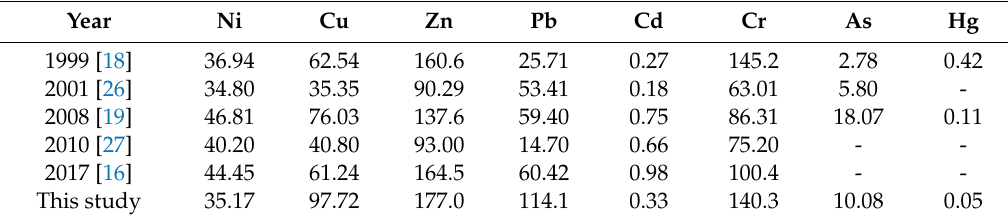
Table 5. Temporal variation of heavy metals in sediments in the Three Gorges Reservoir over the last 20 years (mg /